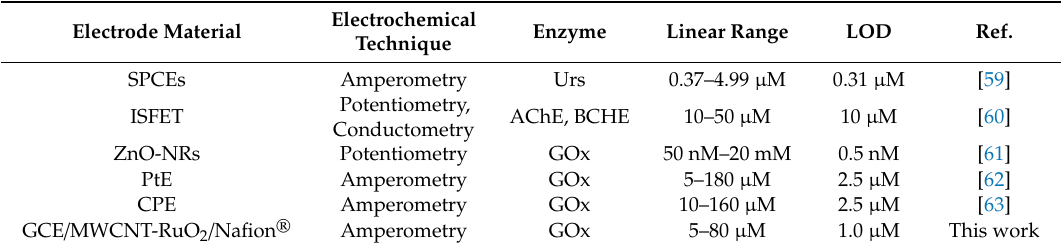
Table 2. Some of enzyme based electrochemical biosensors developed for mercury determination.